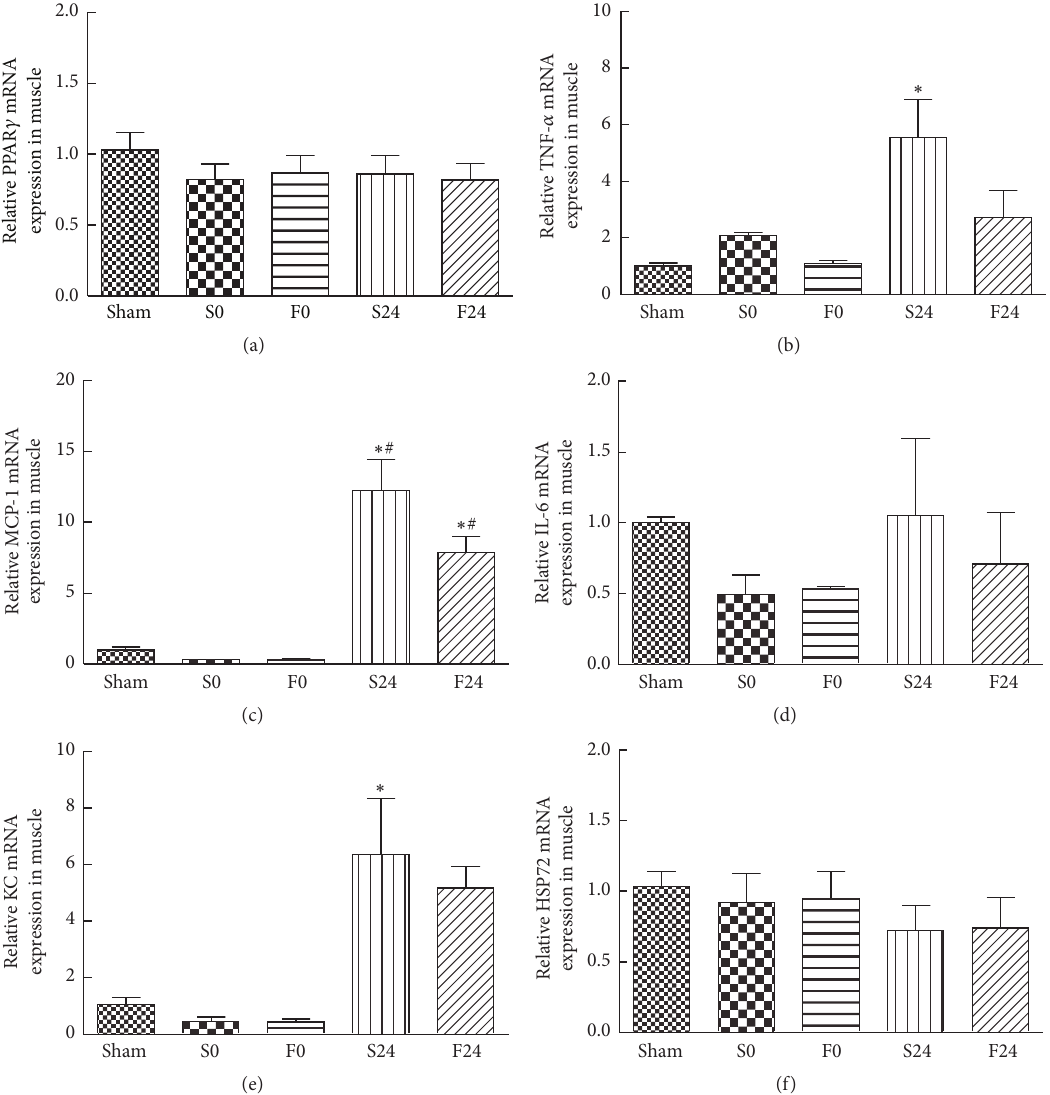
Figure 2: Expression of (a) peroxisome proliferator-activated receptor- 𝛾 (PPAR- 𝛾 ), (b) tumor necrosis factor- 𝛼 (TNF- 𝛼 ), (c) monocyte chemotactic protein-1 (MCP-1), (d) interleukin-6 (IL-6), (e) keratinocyte-derived chemokine (KC), and (f) heat shock protein 72 (Hsp72) mRNAs in muscle tissues. The groups are described in the legend of Figure 1. Data are presented as the mean ± SEM ( 𝑛 = 8 ). Differences among groups were analyzed by one-way ANOVA with Tukey’s post hoc test. ∗ Different from the sham group. # Different from other time points in the same group ( 𝑝 < 0.05